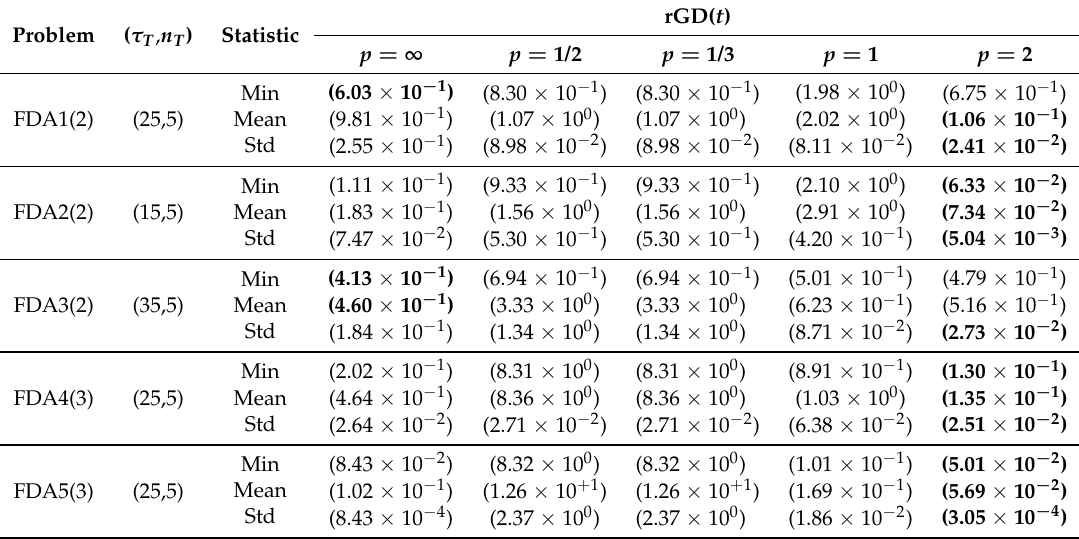
Table 3. Verification of p value in the L p decomposition method for the FDA series problem. The best performance is highlighted with bold font. rGD( t ): dynamic inverse generation